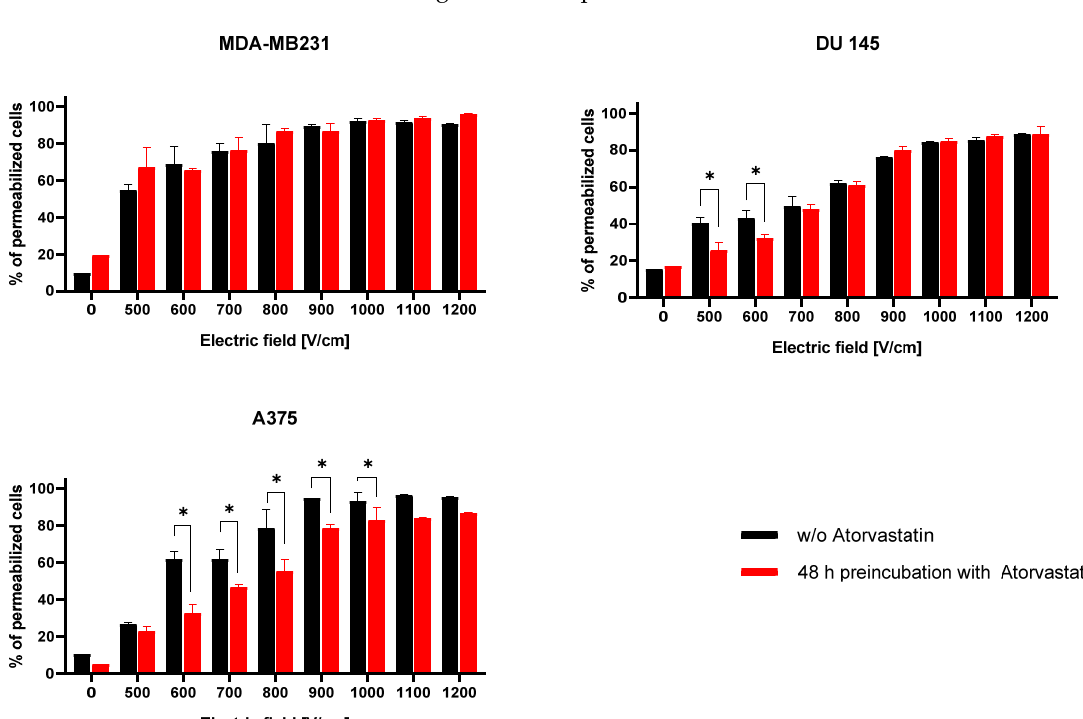
Figure 3. The uptake of Yo-Pro-1 after treatment with PEF ranging from 500 to 1200 V/cm (8 pulses, 1 Hz). The three plots present different cell lines: MDA-MB231, DU 145, and A375. Within one cell line, one culture was treated with 50 nM atorvastatin for 48 h and the other was the control. Cells were treated with PEFs (0, 500–1200 V/cm, 8 pulses, 0.1 ms pulse duration) in the buffer with Yo-Pro-1. Data presented as mean ± SD, * p < 0.05.